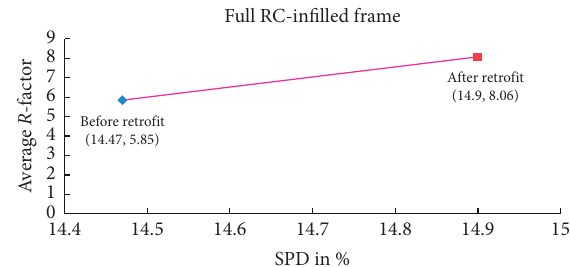
Figure 18: Graph of average R -factor versus structural plan density (SPD).